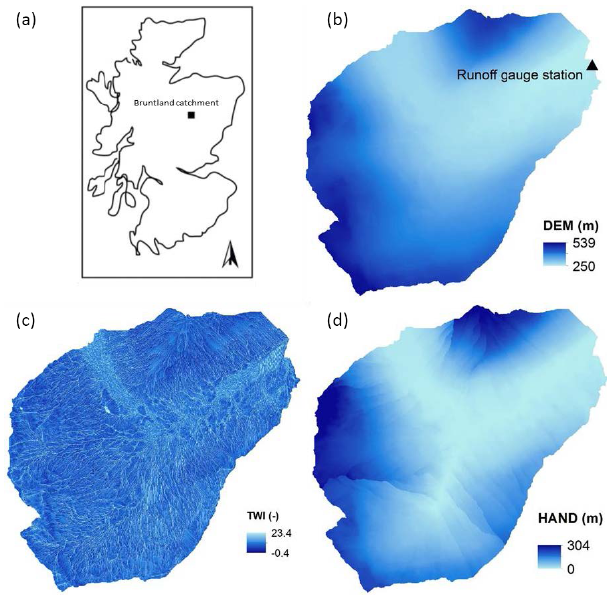
Figure 6. (a) Study site location of the Bruntland Burn catchment within Scotland; (b) digital elevation model (DEM) of the Brunt- land Burn catchment; (c) the topographic wetness index map of the Bruntland Burn catchment; (d) the HAND map of the Bruntland Burn